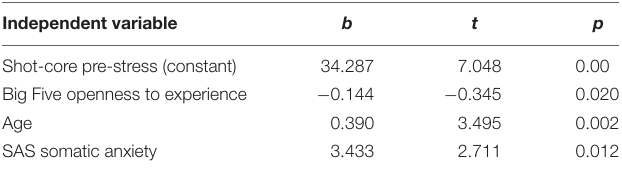
TABLE 4 | Summary of analysis of multiple linear regression for the pre-physical stress condition. Independent variable